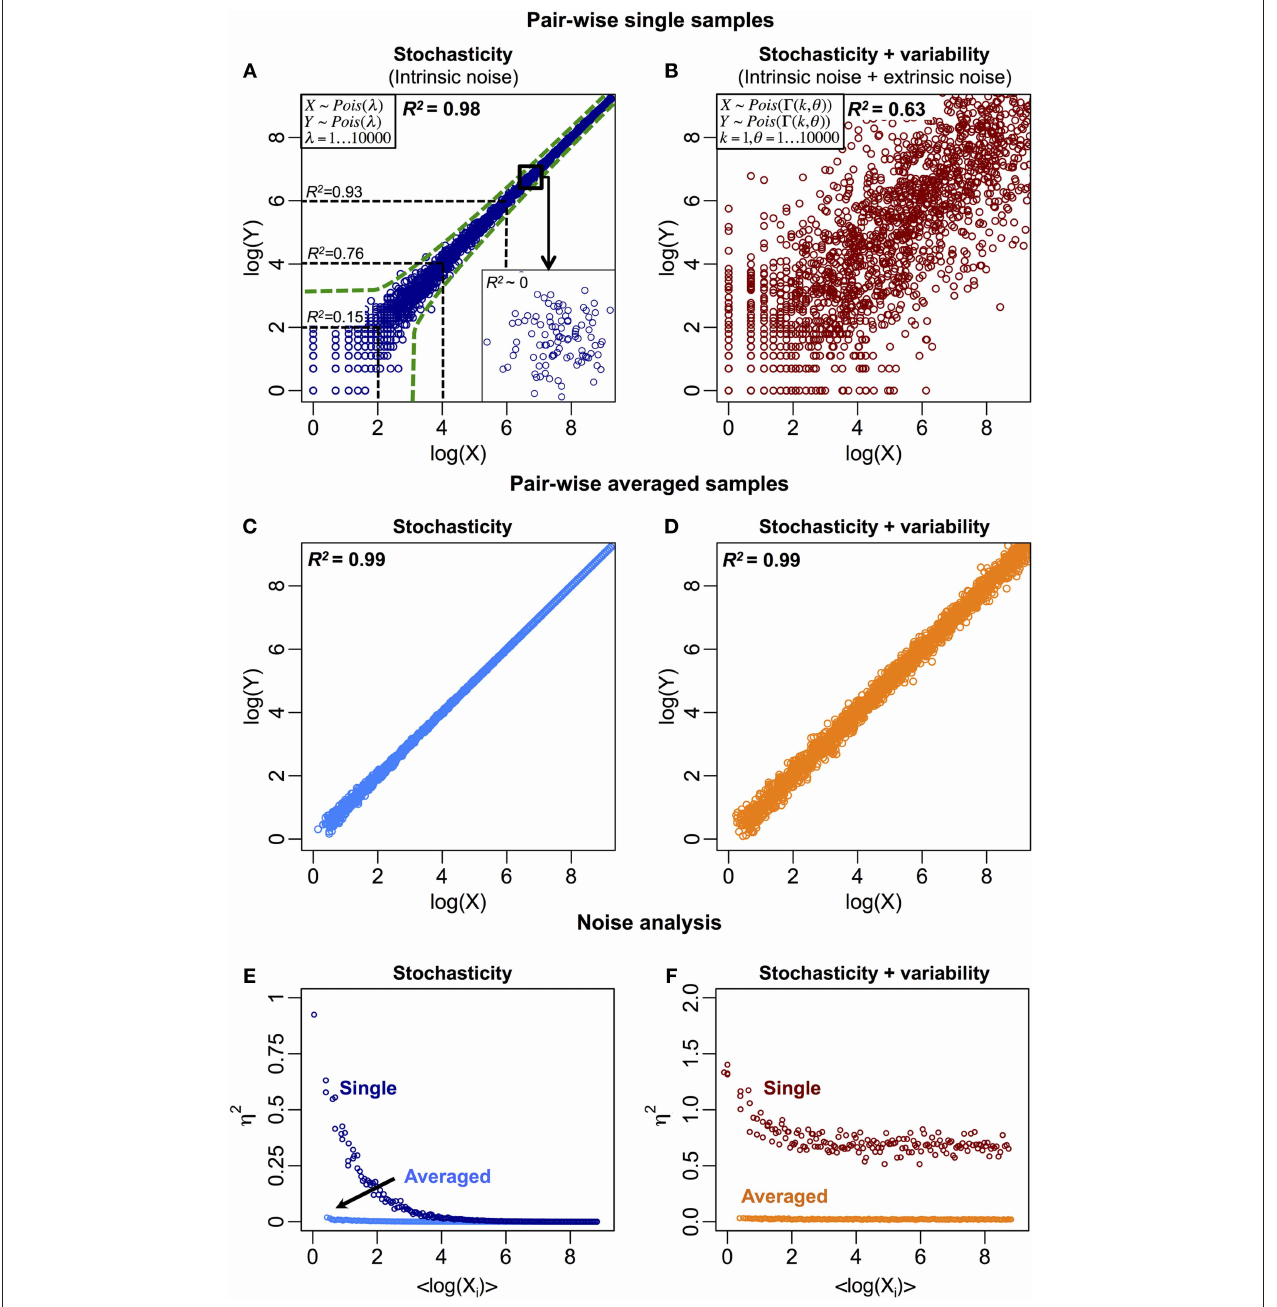
FIGURE 1 | Biological and non-biological noise reduce the between N -dimensional variables, x i and y i are the i th observation ( i = 1 ,..., N ) of X samples correlation structure. (A) Stochastic fluctuations reduce and Y respectively. μ X and μ Y are the statistical means of the two variables. (C) Stochastic and (D) total (stochastic and variable) noise reduce when correlations, especially for low copy number of molecular species ( R 2 ∼ 0 . 15 for log( X ) < 2). The green dotted lines represent the intrinsic noise region single samples are averaged into population. ( E ) and (F) show generated by Poisson process (Raj and van Oudenaarden, 2009). Insert: the correlation structure disappears when zooming at smaller or single molecule scale. (B) Stochastic fluctuations (intrinsic) on variable (extrinsic) noise further reduce the overall correlation structure. Variable noise is represented by a Gamma distribution (Taniguchi et al., 2010). R 2 is obtained by squaring the Pearson product-momentcorrelation coefficient, (cid:3) (cid:2) (cid:3) (cid:2) (cid:2) N N N ( x i − μ X )( y i − μ Y )/ ( x i − μ X ) 2 ( y i − μ Y ) 2 , R = r ( X,Y ) = i = 1 i = 1 i = 1 where X = ( x 1 ,..., x i ,..., x N ) and Y = ( y 1 ,..., y i ,..., y N ) are 2